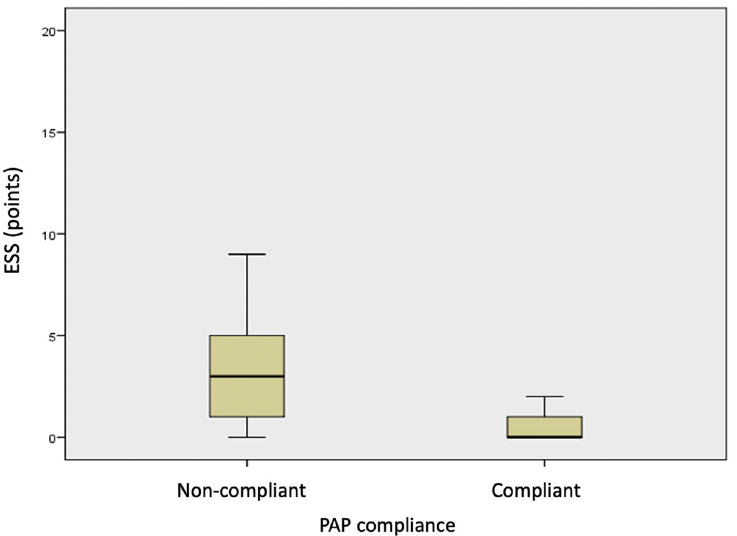
Figure 6. Changes in DBP—baseline versus follow-up. DBP: diastolic blood pressure; PAP: positive airway pressure.